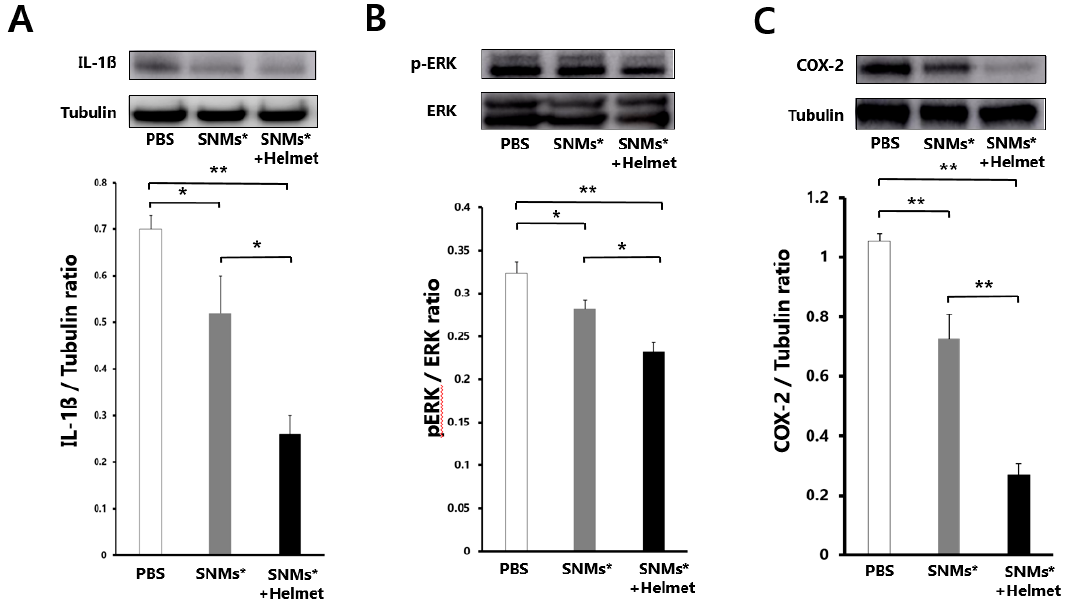
Figure 8. Western blot analysis after 3 days of ICH induction in the PBS, SNMs*, and SNMs*+Helmet groups. Photographic images and quantification analysis of ( A ) normalized IL-1ß, ( B ) proportion of extracellular signal-regulated kinase (ERK) and phosphorylated extracellular signal-regulated kinase (pERK), ( C ) normalized cyclooxygenase-2 (COX-2). (* p < 0.05, ** p < 0.005; n = 3 for each group in each test).